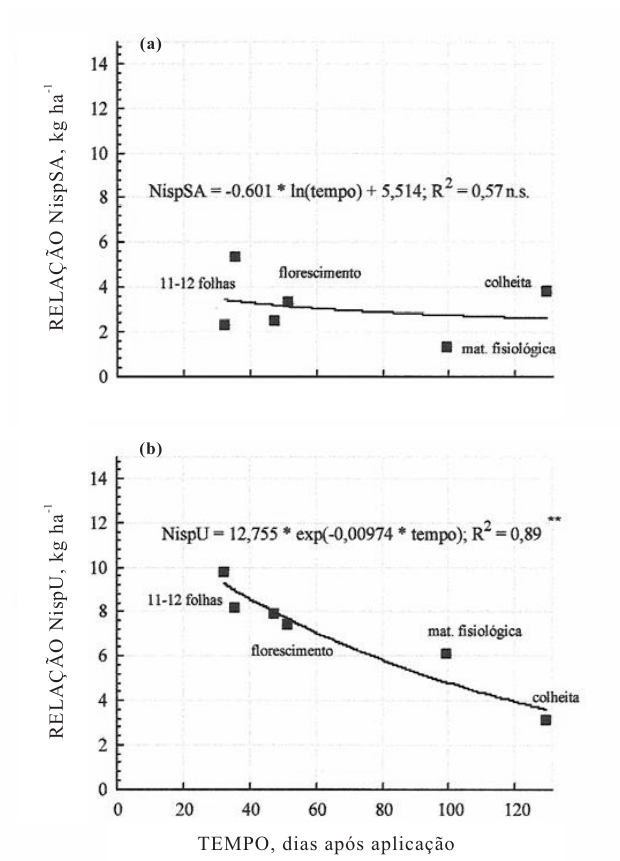
Figura 4. Nitrogênio imobilizado no solo proveniente do sulfato de amônio ( NispSA ) (a) e da uréia ( NispU ) (b), após a aplicação em cobertura na entrelinha das fileiras de plantas de milho, em duas safras consecutivas (1999–2001), em sistema plantio